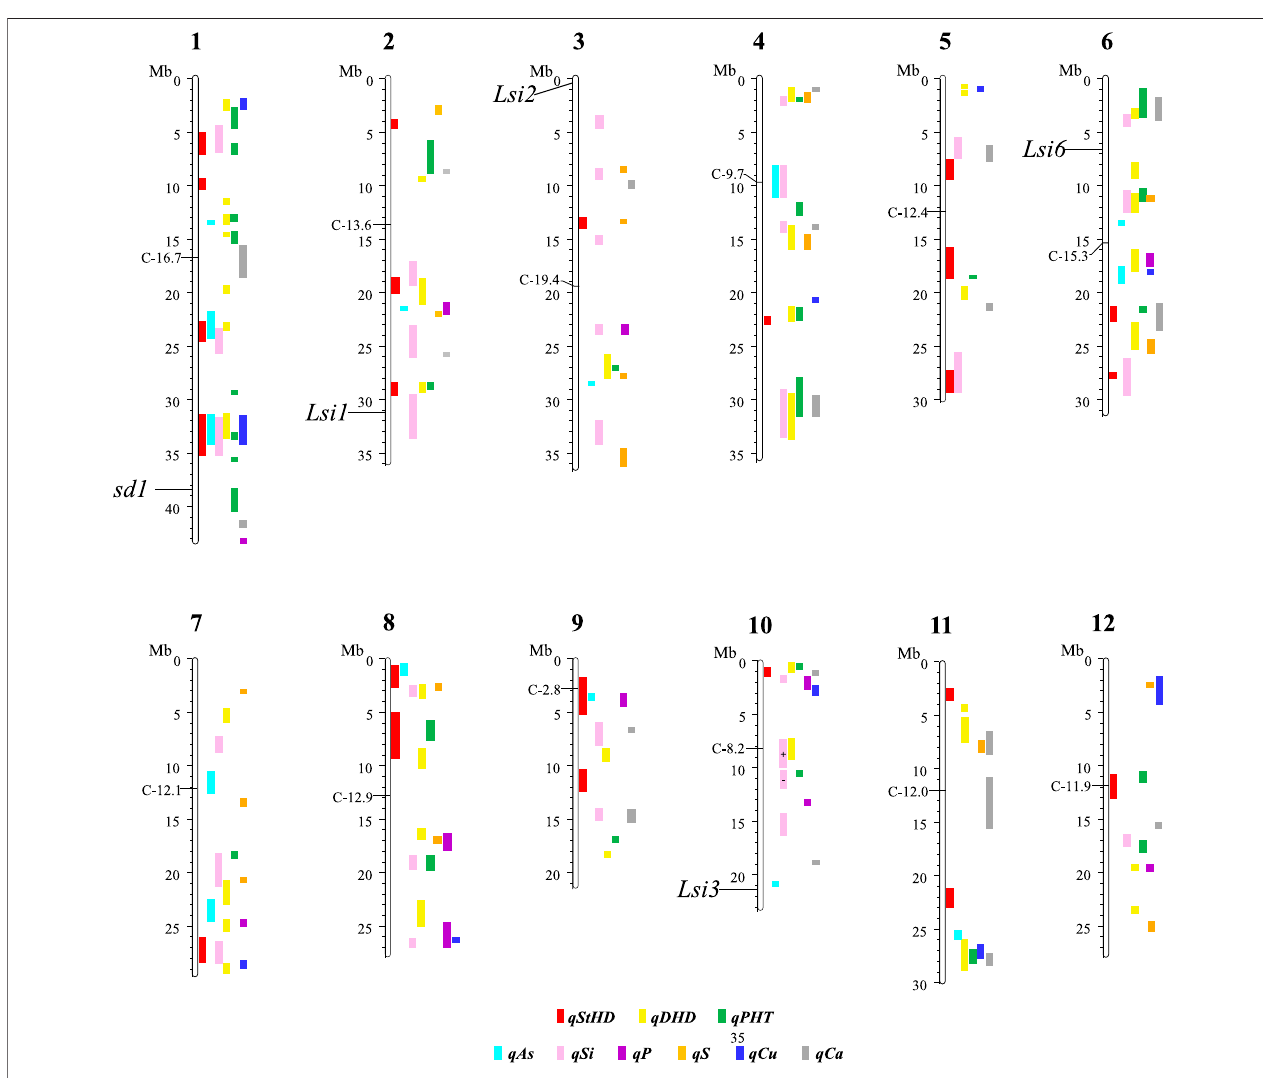
FIGURE 3 | The physical position of the QTL for straighthead disease severity (qStHD), days to heading (qDHD), plant height (qPHT), hull silica concentration (qSi), and grain concentrations of arsenic (qAs), phosphorus (qP), sulfur (qS), calcium (qCa), and copper (qCu) identi fi ed by genome-wide association (GWA) mapping in the USDA Rice Minicore (RMC) with 3,200,320 SNP markers across the entire rice genome. Chromosome and megabase (Mb) positions of QTL and centromeres (C-Mb) are based on the Os-Nipponbare-Reference-IRGSP-1.0 assembly (Kawahara et al., 2013). The details of the QTL and their distinguishing SNPs are organized per trait with Si in Table 2 , StHD in Table 3 , As in Table 4 , and the remaining traits in Supplementary Table S2 .